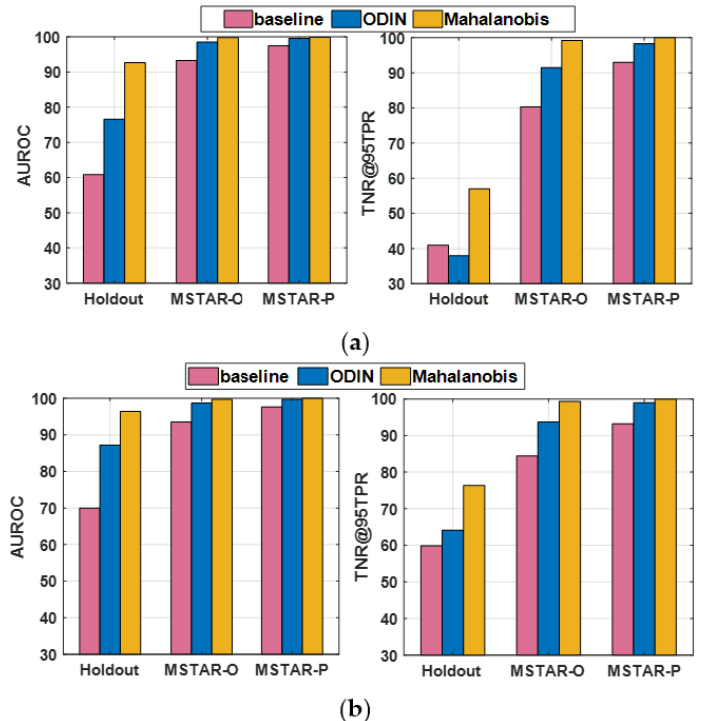
Figure 9. Performance comparison of different OOD detection methods. ( a ) J = 1; ( b ) J = 3.